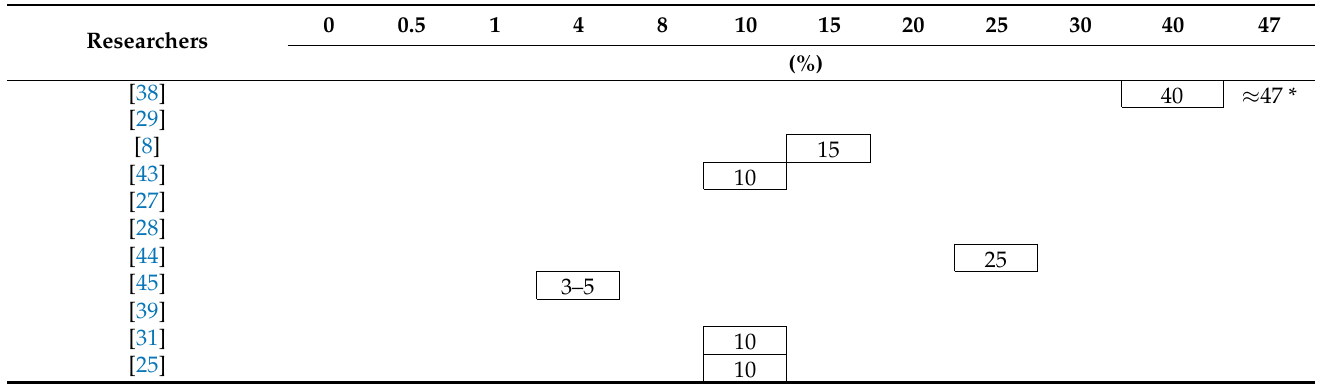
Table 5. Binder levels added to densified